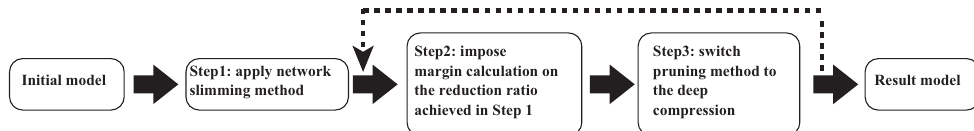
Figure 4. A flow chart of the three-step procedure of our proposed method.